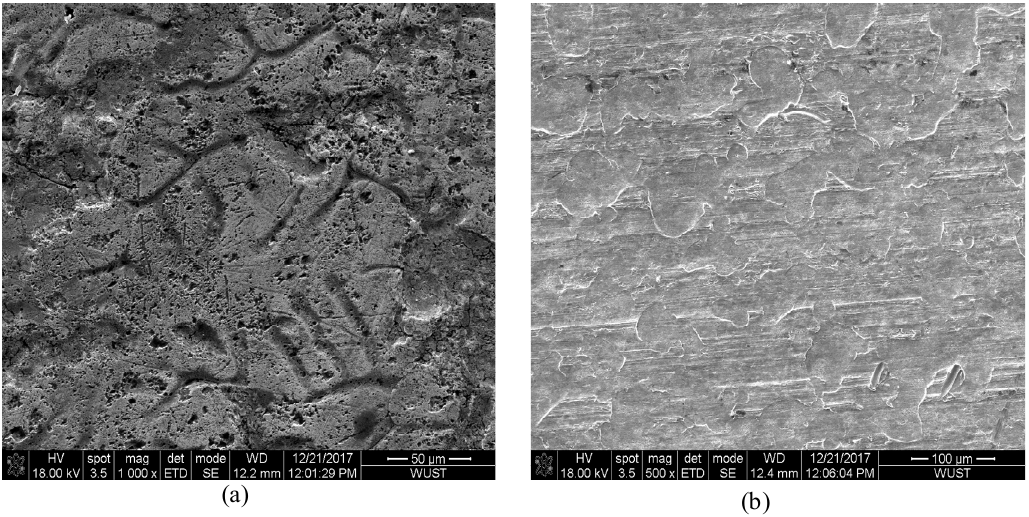
Figure 2. Measurement results of surface morphology: ( a ) Original steel sheet with zinc coating, ( b ) Steel sheet after acid pickling without zinc coating. Table 1. Detailed results of uniaxial tensile